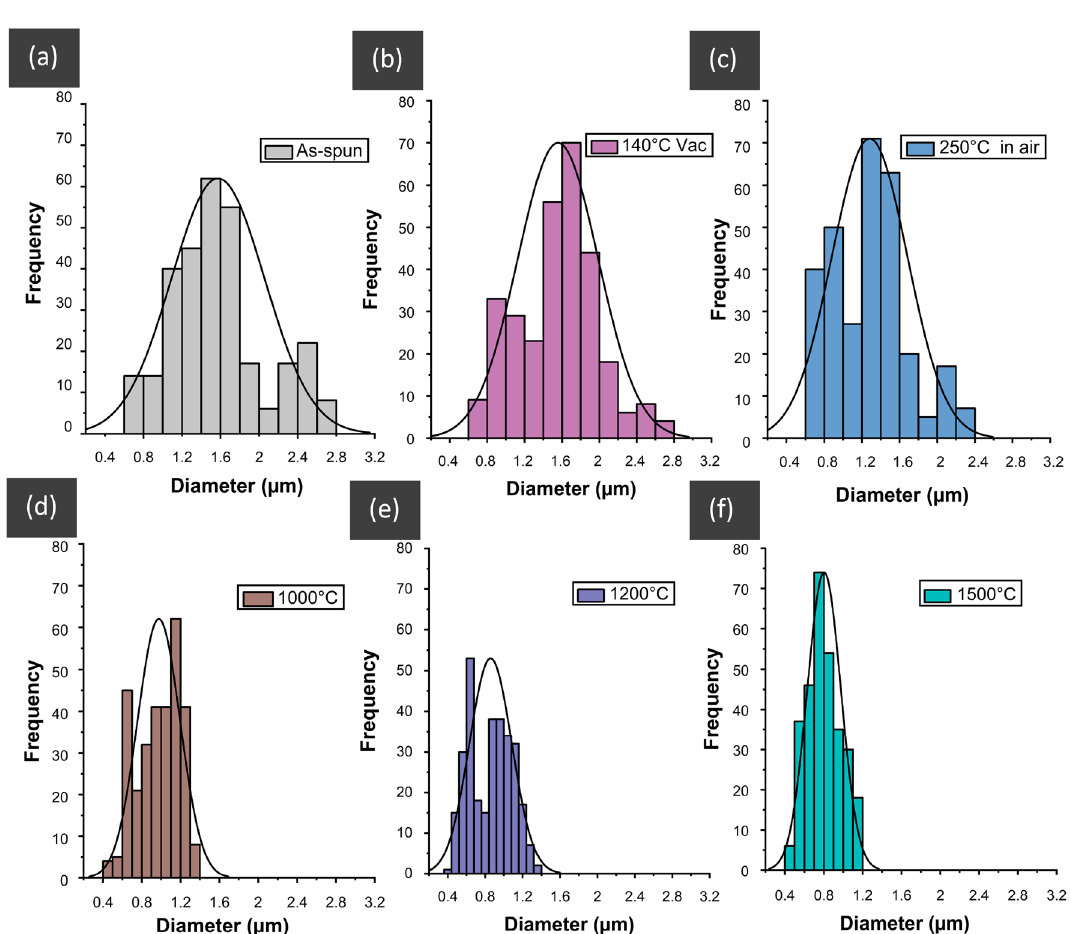
Figure 6. Histogram plots for the diameter distribution for the electro-spun (ASL-ESL) lignin fibres: as-spun ( a ), vacuum-heated at 140 °C ( b ), thermo-oxidative stabilised at 250 °C ( c ), and carbonised at 1000 °C ( d ), 1200 °C ( e ) and 1500 °C in nitrogen ( f ). The histograms have been overlaid with a normal diameter distribution curve for each data set. Origin (Pro), version 2020 . OriginLab Corporation, Northampton, MA, USA. https:// www. origi nlab.